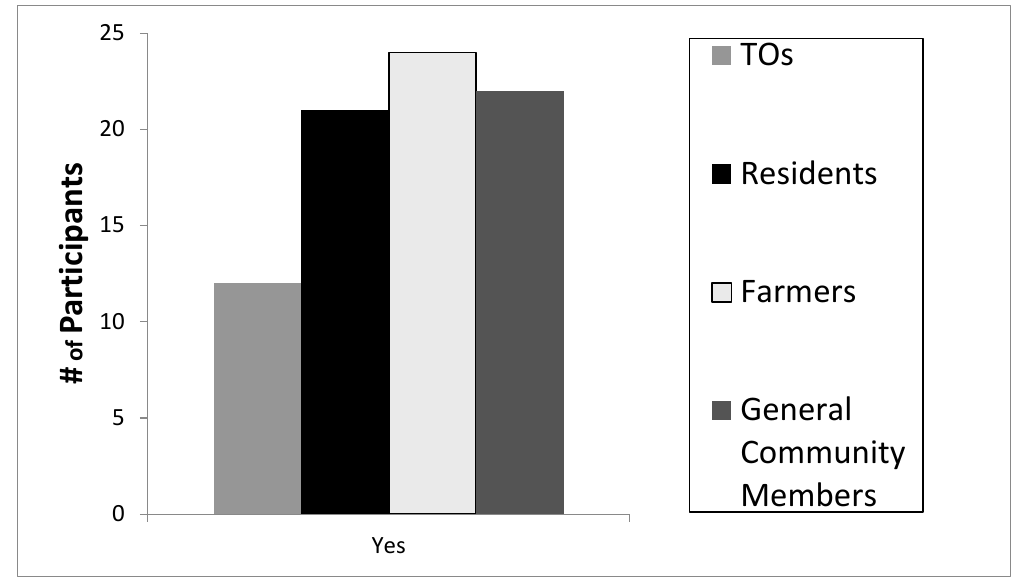
Figure A10. Knowledge of water quality reports for the Great Barrier Reef (GBR).